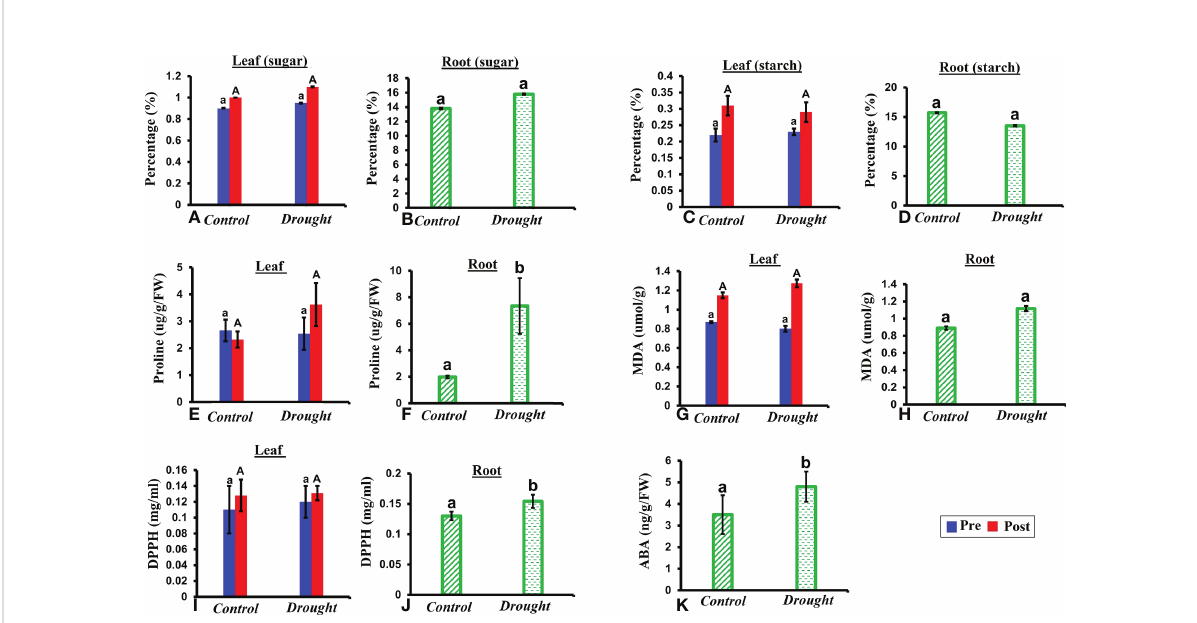
FIGURE 3 Biochemical responses of P.strobus seedlings to drought. (A, B) total soluble sugar content in leaves and root of control and stressed plants (C, D) total starch content in leaves and roots 32 DAT (E, F) proline content in leaves and root samples of control and drought plants (G, H) lipid peroxidase activity-MDA content in leaves and root samples of control and drought plants (I, J) antioxidant assay measured via DPPH content in root and leaf samples 32 DAT (K) ABA content in roots 32 DAT. Results denote that severe drought signi fi cantly in fl uences root proline and DPPH activity compared to a non-signi fi cant increase in leaves. In addition, a non-signi fi cant increase is observed in sugar (leaf and root), lipid peroxidase activity (leaf and root) with a non-signi fi cant decrease noted for starch content (leaf and root). Means denoted with different letters indicate signi fi cance at